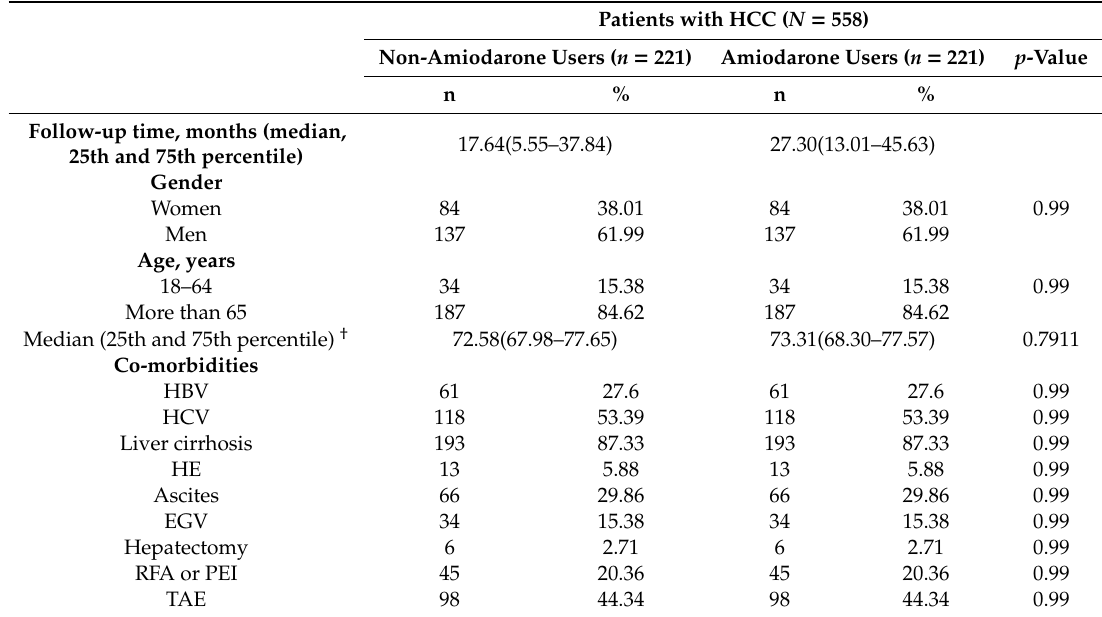
Table 1. Characteristics of arrhythmia patients with HCC according to use of